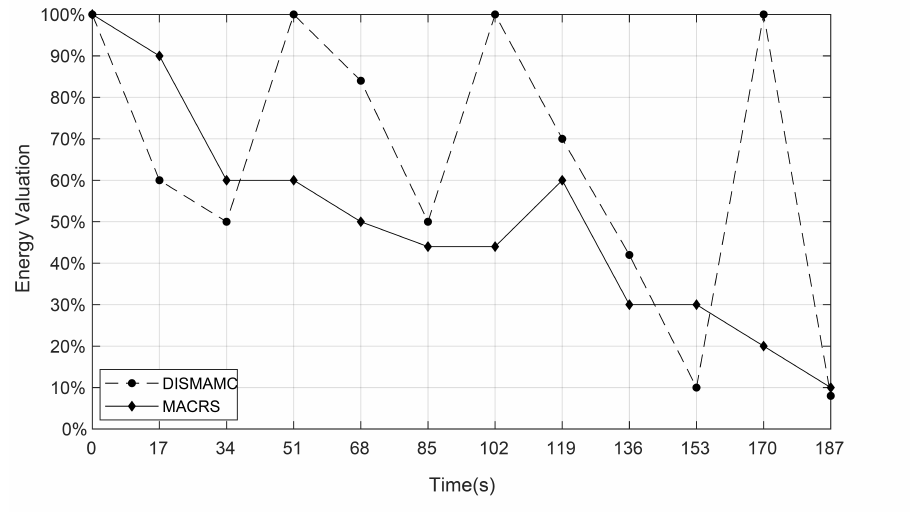
Figure 13. Resource